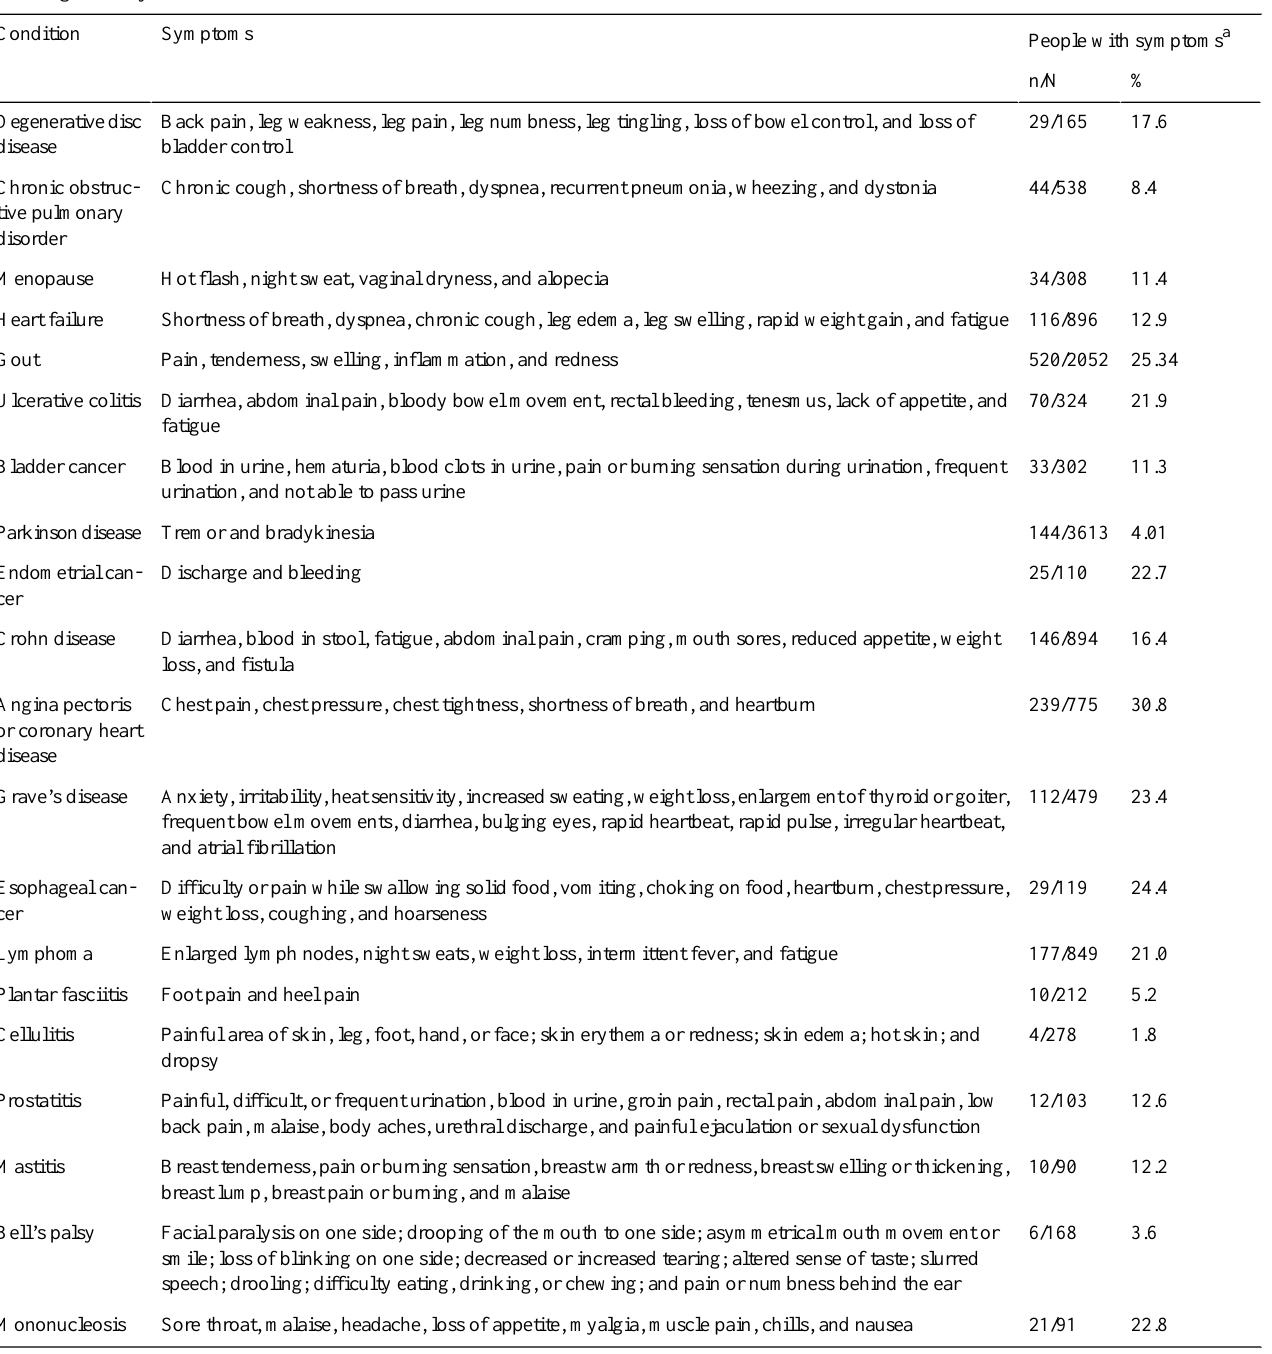
Table 1. Conditions analyzed, symptoms associated with them, and the percentage of people who asked about the symptoms before their first query indicating that they have the